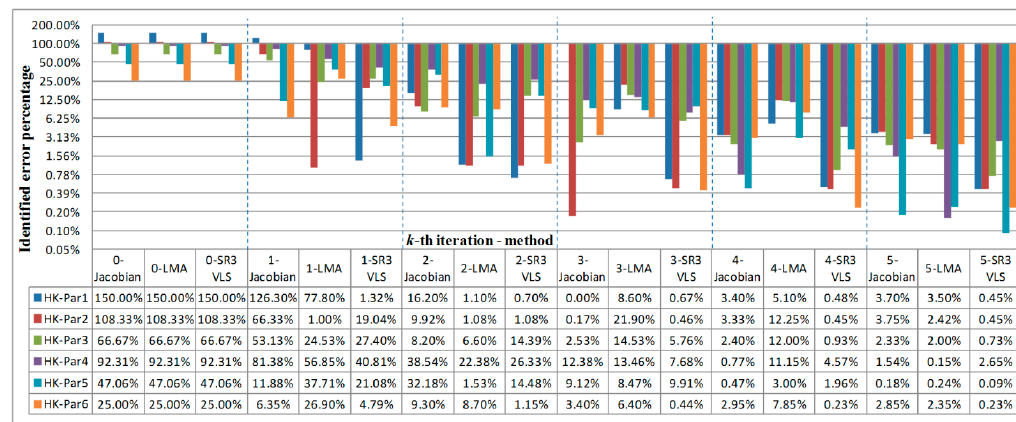
Figure 4. Error percentage of identified hydraulic conductivity using Jacobian quasi-Newton, LMA, and SR1 VLS quasi-Newton algorithms during iterations across multiple zones in Experiment 1.